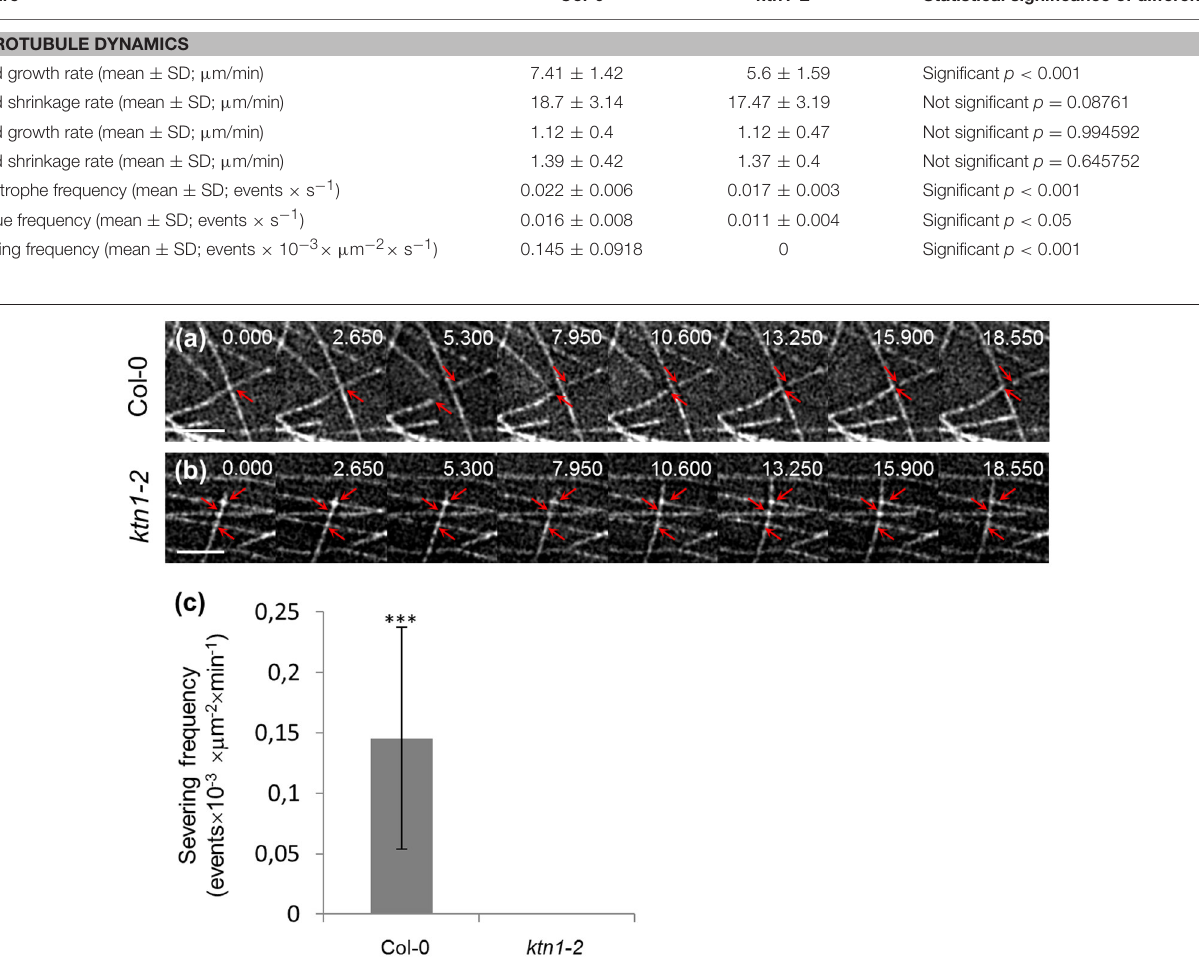
FIGURE 4 | Recording of severing events in Col-0 and ktn1-2 petiole epidermal cells expressing a GFP-TUA6 microtubule marker with time-lapsed 2D SIM. The spotted appearance of microtubules owes to the inhomogeneous incorporation of TUA6-GFP in the microtubule lattice ( a,b ; see Section Discussion by Komis et al., 2014). Time lapsed stills of petiole epidermal cell region showing severing in Col-0 (a) and absence of severing in ktn1-2 (b) . (c) Quantitative comparison of severing frequencies in petiole epidermal cells of Col-0 and ktn1-2 (*** p < 0.001; N = 19 cells from Col-0 and N = 16 cells from ktn1-2 ). Severing frequencies can be found in Table 1 . Arrows in (a) show microtubule crossover in first 2 frames and the microtubule ends resulting from severing in the rest of the frames. In (b) arrows in first frame show 3 microtubule crossovers where no severing is observed. Scale bars: 2 µ m. Numbers at (a,b) correspond to time